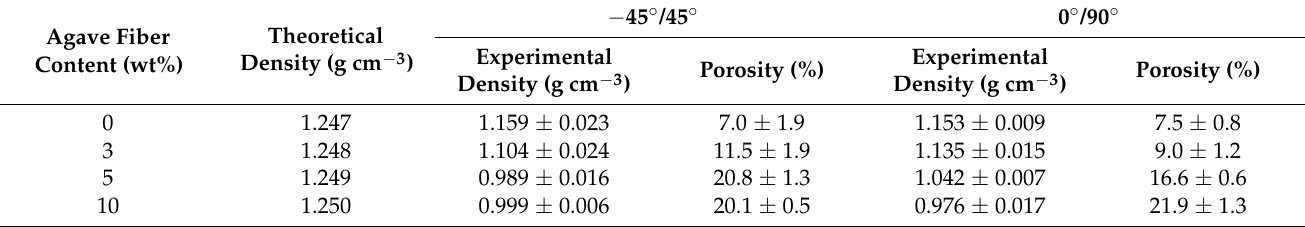
Table 2. Effect of agave fiber content on apparent density and porosity of the agave fibers/PLA printed pieces. Agave